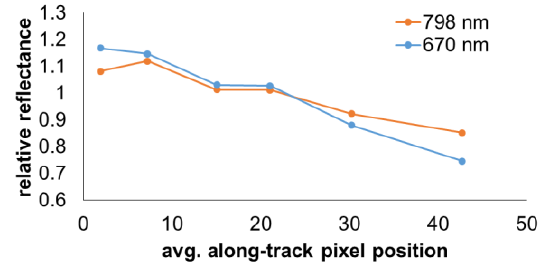
Figure 4 Average reflectance per IC for 670 nm and 798 nm in relation to the average (avg.) along-track pixel position In alignment with the visual impression of Figure 2, the average reflection of both wavelength decreases with increasing across track position. Additionally, the average change is higher at 670 nm (42%) than at 798 nm (23%). For IC3 and IC4 hardly any difference is observable. The average across-track pixel position of IC3 and IC4 is 15px and 21px an thus, within only 5px from the nadir viewing direction The relative reflectance of these two ICs only differ by less than 0.004 for both wavelength.